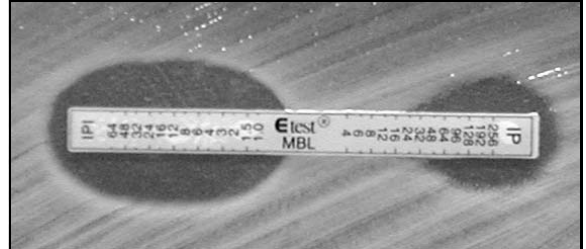
Figura 6 – Amostra clínica apresentando teste fenotípico positivo para a produção de MßL por meio da metodologia de Etest ® . A CIM observada pela amostra-teste na extremidade da fita contendo somente imipenem (IP) é de 48µg/ml, ao passo que, na outra extremidade, a amostra testada demonstrou uma CIM ≤ 1µg/ml contra imipenem